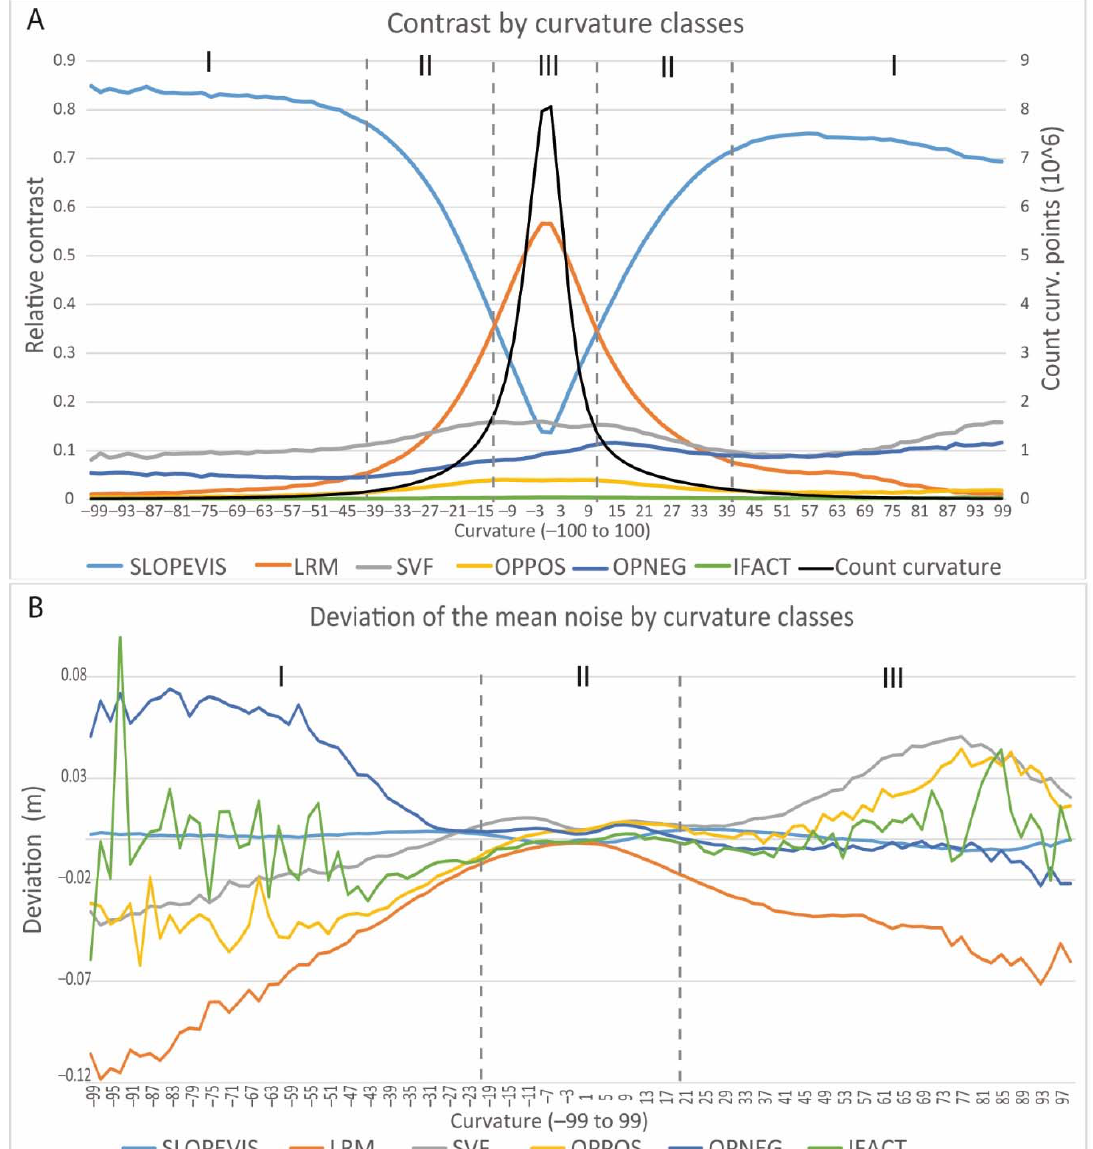
Figure 9. Contrast ( A ) and mean noise ( B ) by curvature classes and VTs.